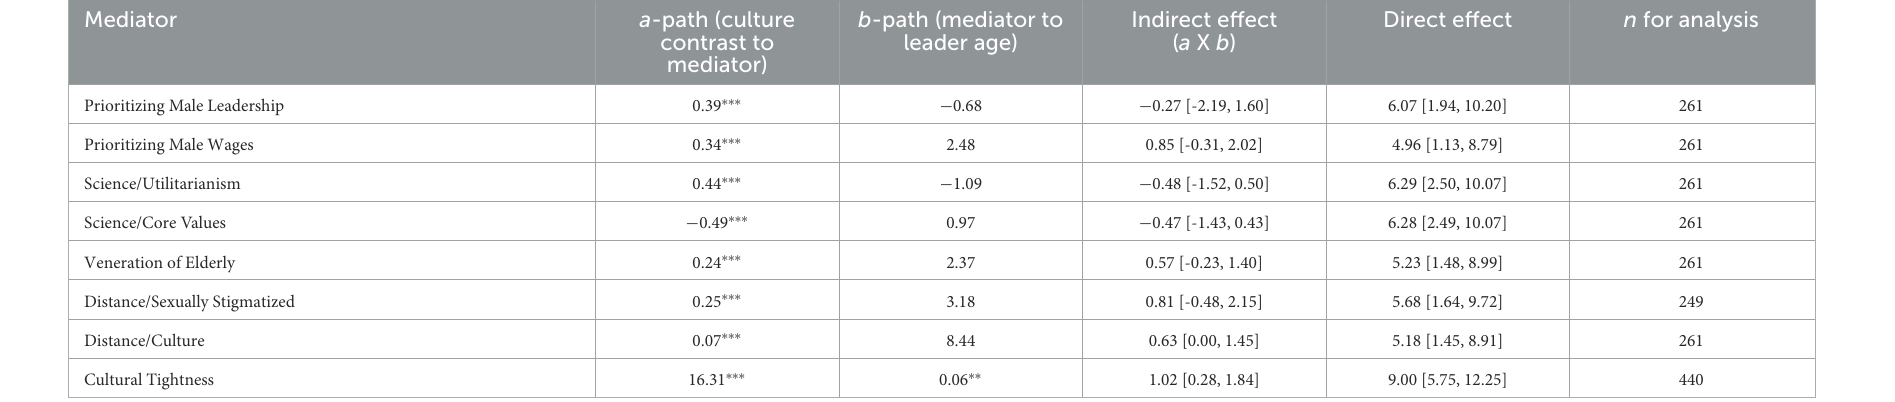
TABLE 2 Indirect effects from culture contrast to political leader age (Study